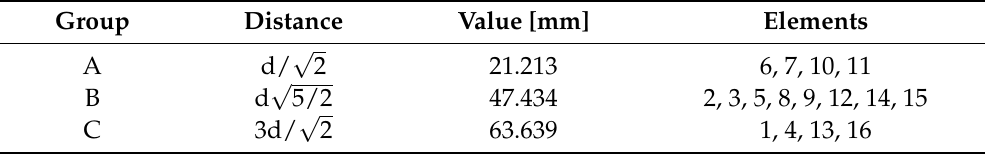
Table 1. Phased-array element separation into groups, according to the distance from each patch center to the overall array central point, where w is the patch width and d is the element separation. Group